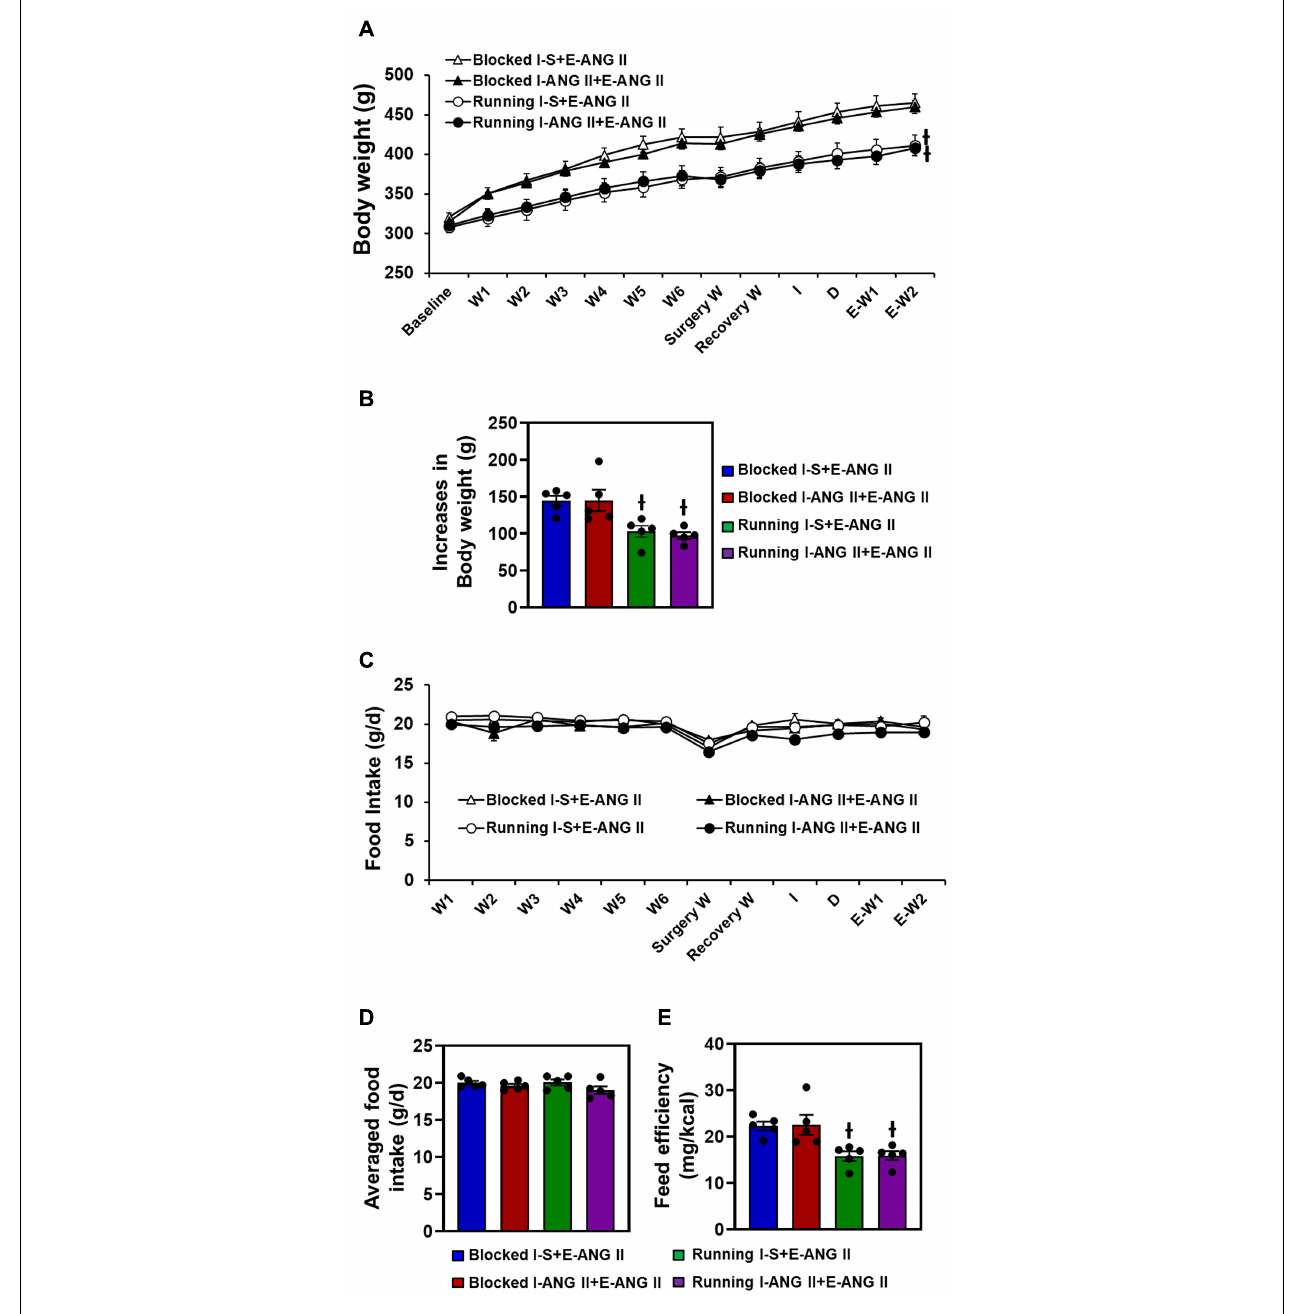
FIGURE 3 | Body weight changes (A,B) , daily and averaged food intakes (C,D) and feeding efficiency (E) in sedentary (Blocked) and exercise (Running) rats with Induction-Delay-Expression (I-D-E) paradigm. ( n = 5/group; one-way ANOVA was used for analysis followed by Tukey’s post-hoc tests. p < 0.05; -I vs. blocked